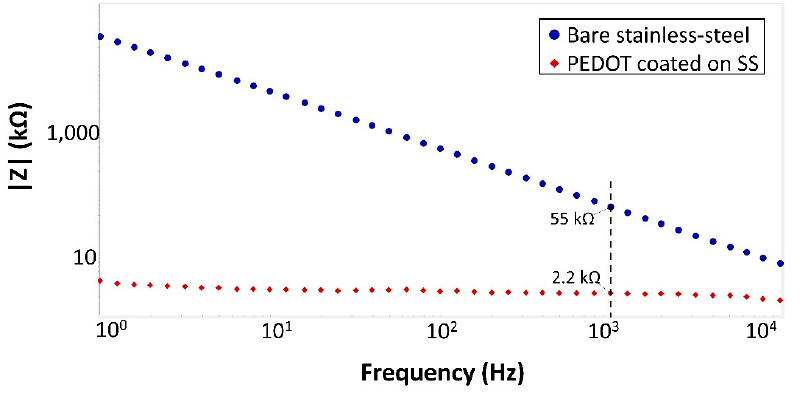
Figure 8. Impedance spectra comparing PEDOT-coated stainless steel electrode with the uncoated stainless steel